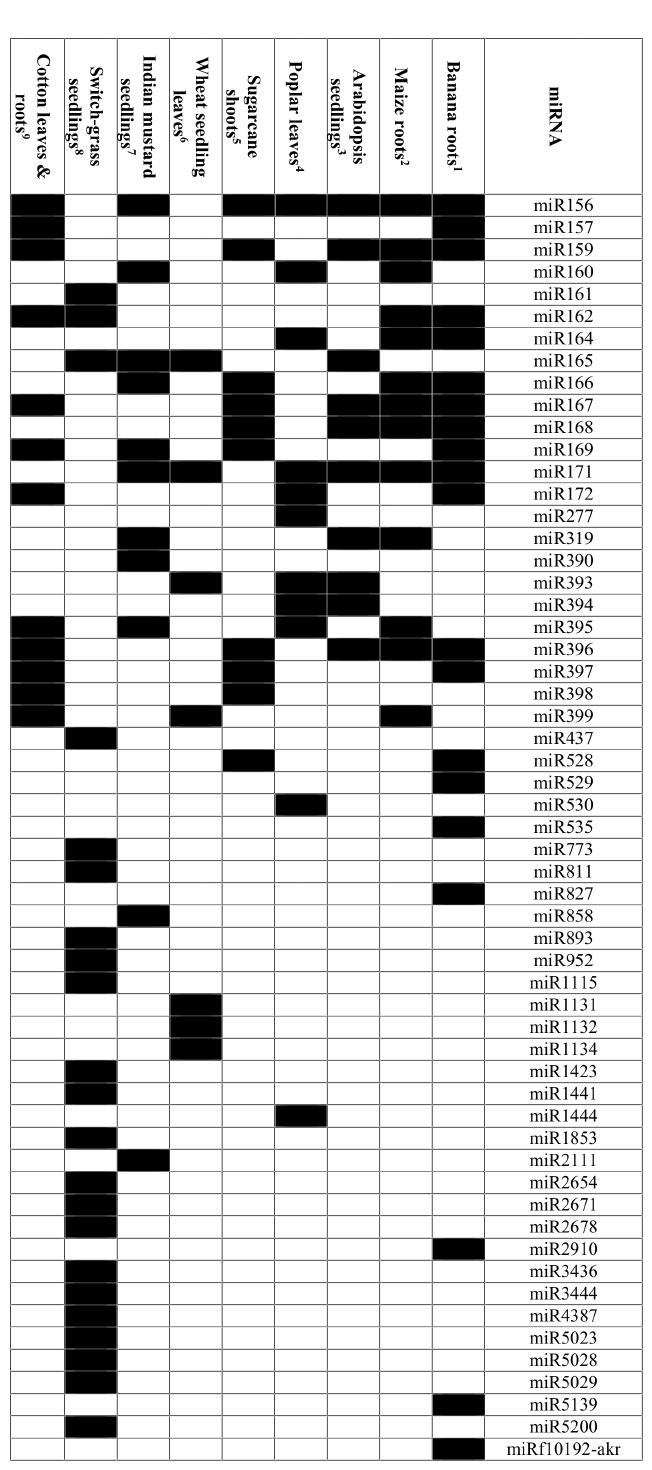
Fig 6. Salt-stress responsive miRNAs. Salt-stress responsive miRNAs are the statistically significant differentially-expressed miRNAs reported in the following studies: 1. Present study with Musa acuminata roots; 300 mM NaCl treatment; sRNA-Seq; log 2 fold change (cid:1) 1 or (cid:3) -1 and FDR < 0.05; 2. Zea mays roots; 200 mM NaCl treatment; miRNA microarray; P-value < 0.01 [10]; 3. Arabidopsis thaliana seedlings; 300 mM NaCl treatment; miRNA microarray; fold change > 1.5 and q value < 0.001 [11]; 4. Populus euphratica shoots; 200 mM NaCl treatment; sRNA-Seq; miRNAs with reverse expression with their targets [12]; 5. Saccharum